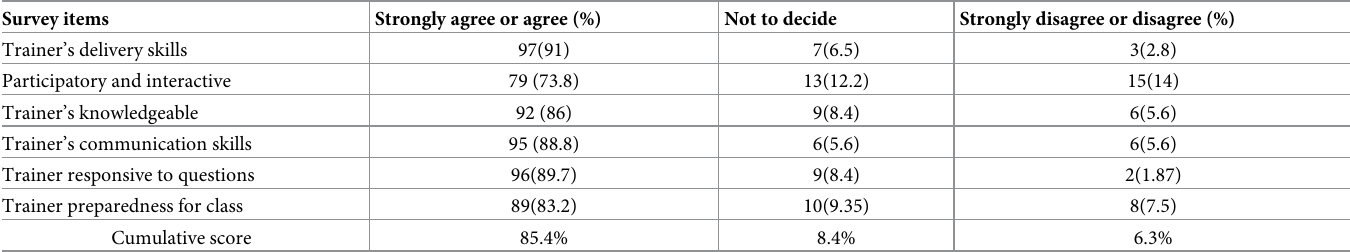
Table 4. Classifications of trainer’s knowledge and skills in Amhara Public Health Institute Dessie Branch, northeast Ethiopia, October/2019 (N = 107).